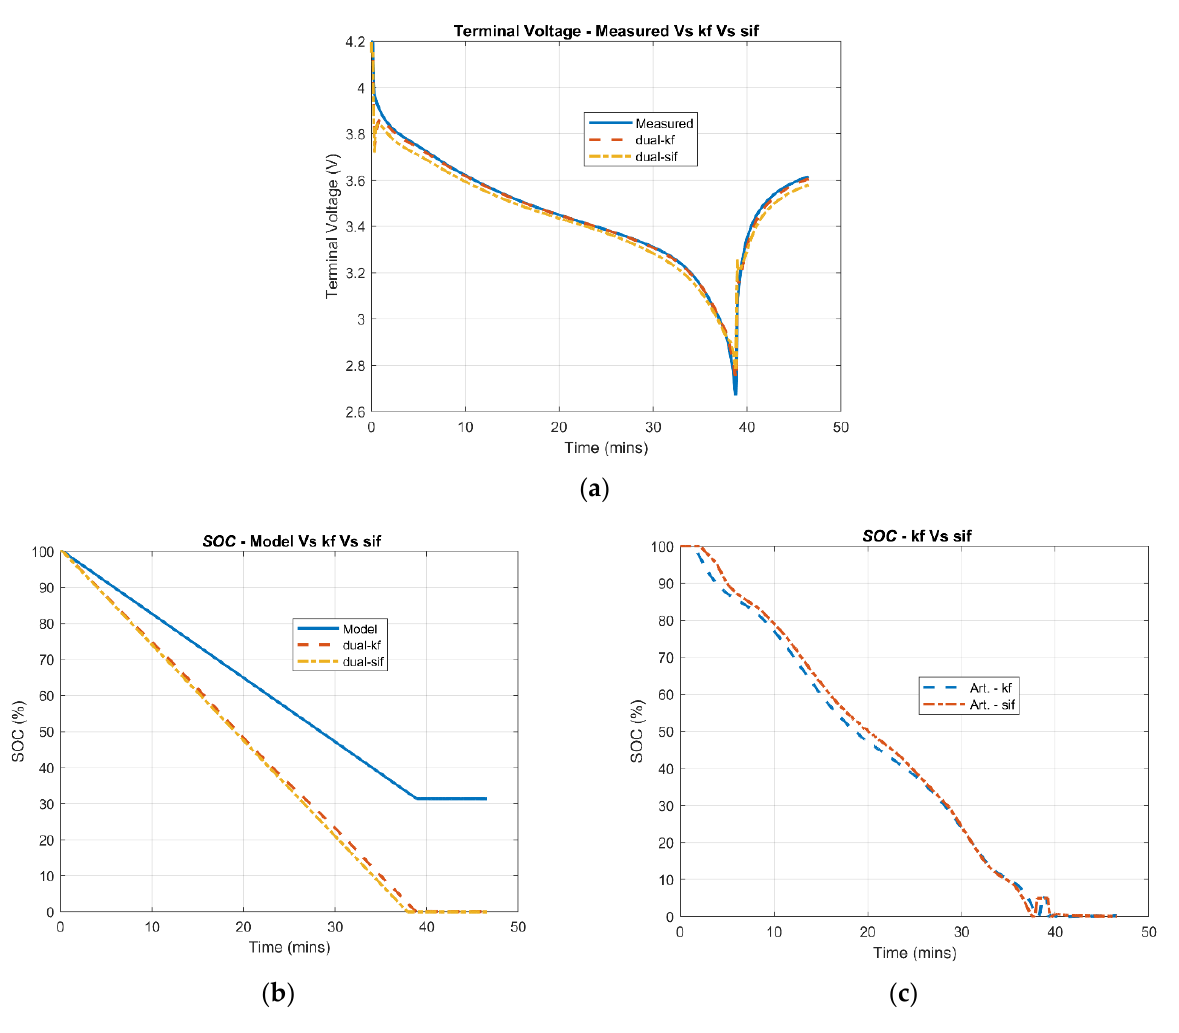
Figure 8. 600th Cycle Estimation Results: ( a ) Terminal Voltage, ( b ) SOC Estimate, ( c ) SOC Artificial Figure 8. 600thCycleEstimationResults: ( a )TerminalVoltage,( b ) SOC Estimate,( c ) SOC ArtificialMeasurement. Measurement. Table 4. RMSE